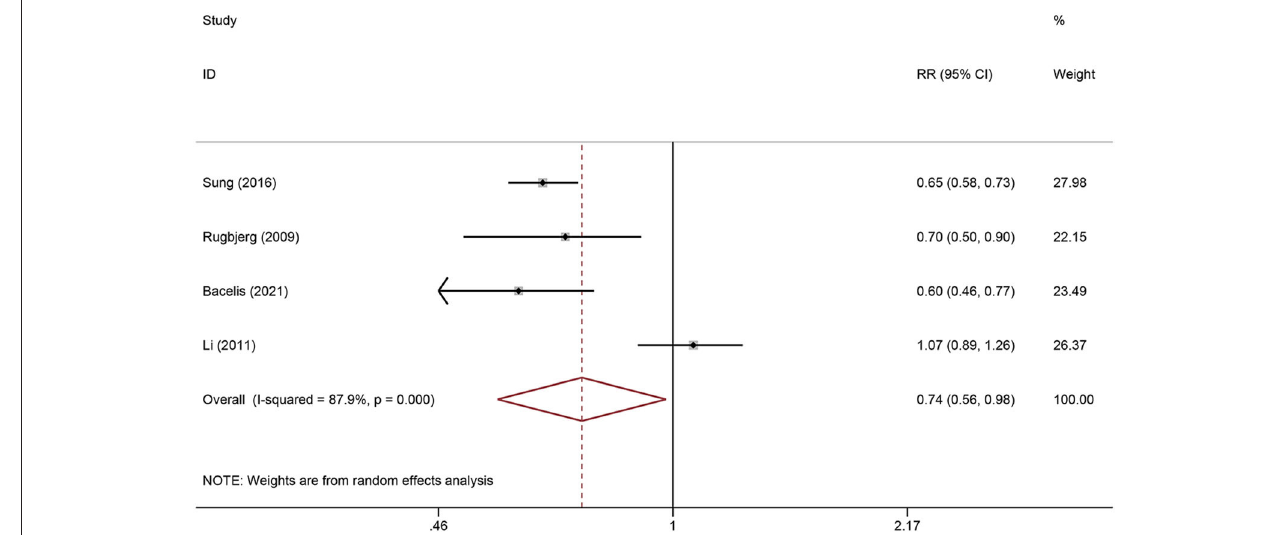
FIGURE 2 | Forest plot of the associations between Rheumatoid arthritis and risk of Parkinson’s disease.